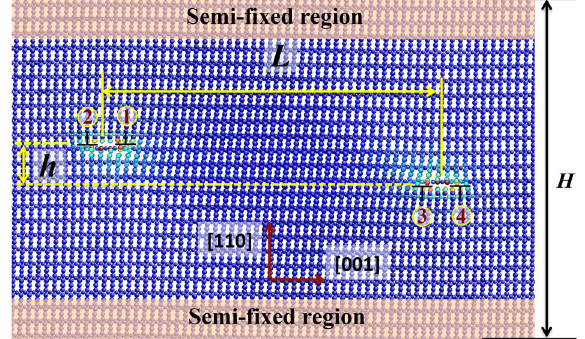
Fig. 1 a Simulation set-up — two full dislocations are separated about L = 26.4 nm along the horizontal direction and h nm along the vertical direction. The semi- fi xed regions, 1.5 nm from the surfaces, retain applied shear strain and mimic bulk properties of Al 2 Cu. Atoms are colored according to their excess energy. The symbol “ ⊥ ” indicates the position of dislocation